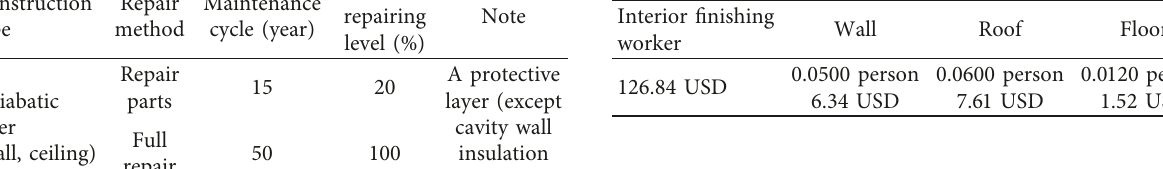
Table 3: Repair and replacement costs of insulation. Construction